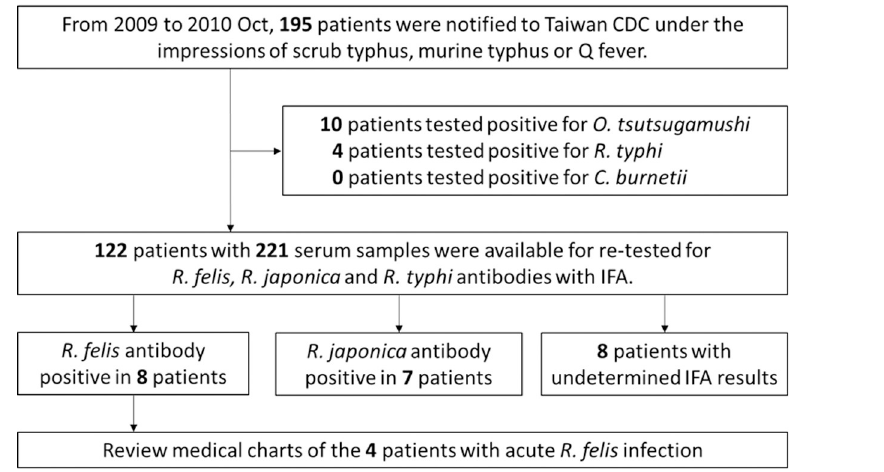
Fig 1. Study design flowchart. The flow diagram showed the experimental design of the